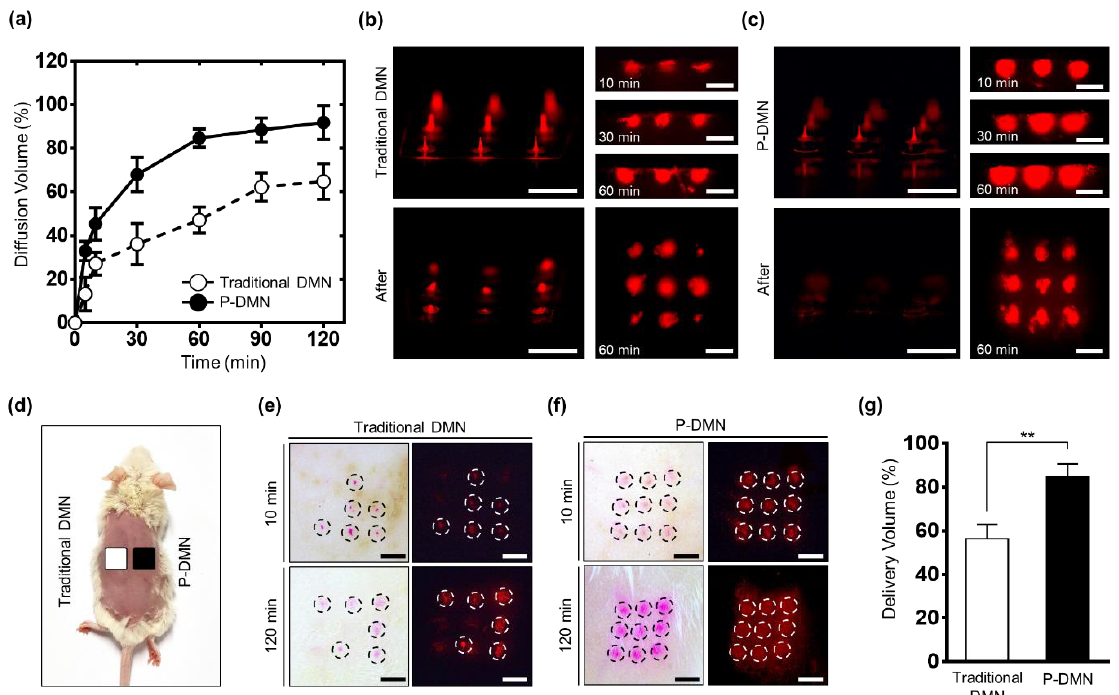
Figure 4. Skin dissolution and permeation evaluation of dissolving microneedles (DMNs). ( a ) Comparison of DMN diffusion pattern in vitro: the micro-pillar integrated DMN (P-DMN)